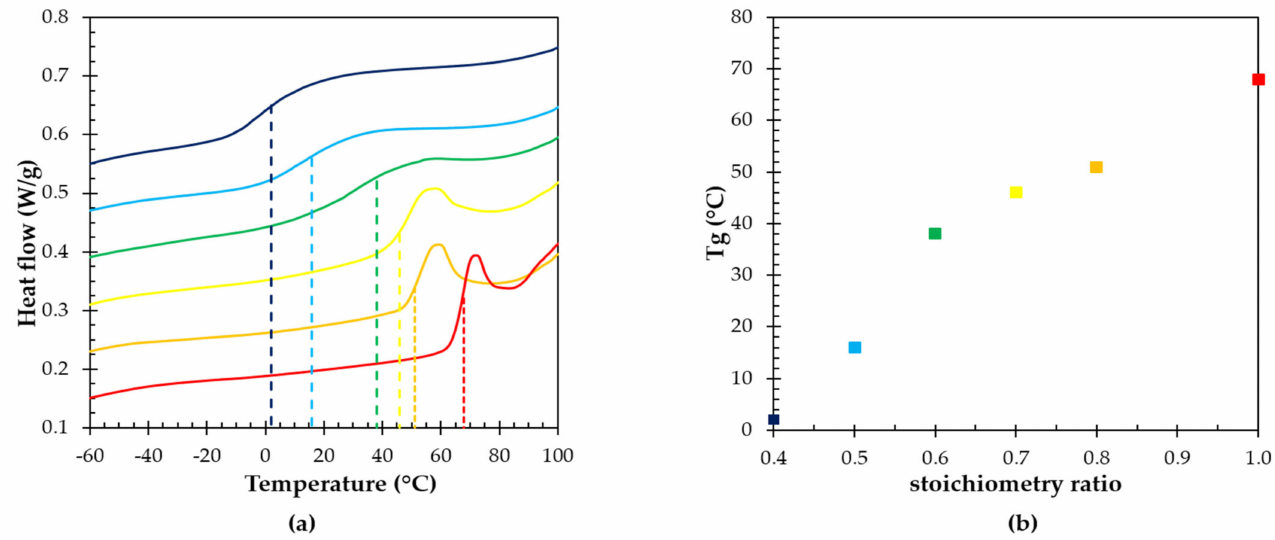
Figure 3. ( a ) DSC curves for thermoreversible networks; ( b ) glass transition temperature of the RPN as a function of stoichiometric ratio ( r ): r = 1 (red), r = 0.8 (orange), r = 0.7 (yellow), r = 0.6 (green), r = 0.5 (light blue), and r = 0.4 (dark blue). The glass transition is visible as an endothermic step in the heat flow signal as function of temperature. By increasing the stoichiometric ratio, the glass transition T g increases due to an increase in crosslink density. Table 2. Equilibrium concentration of Diels–Alder cycloadducts at 25 ◦ C, glass transition temperature, Young’s modulus, fracture stress, and fracture strain of synthesized RPNs that differ in stoichiometric ratio r .